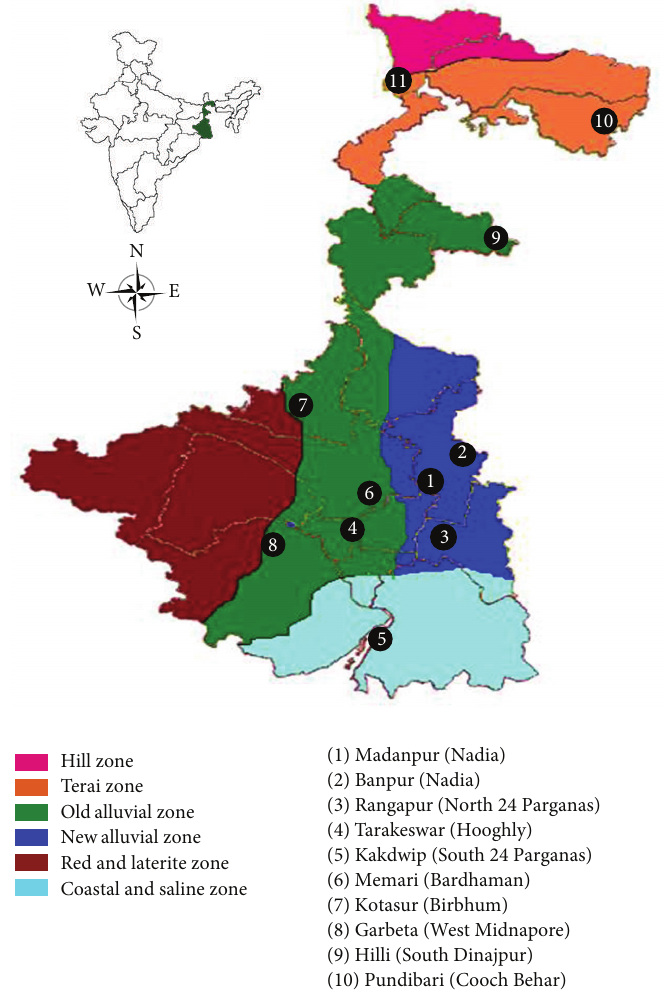
Figure 1: Agroclimatic zones of West Bengal showing localities of collection of pointed gourd accessions. Collection sites are marked with a circle and numbered from 1 to